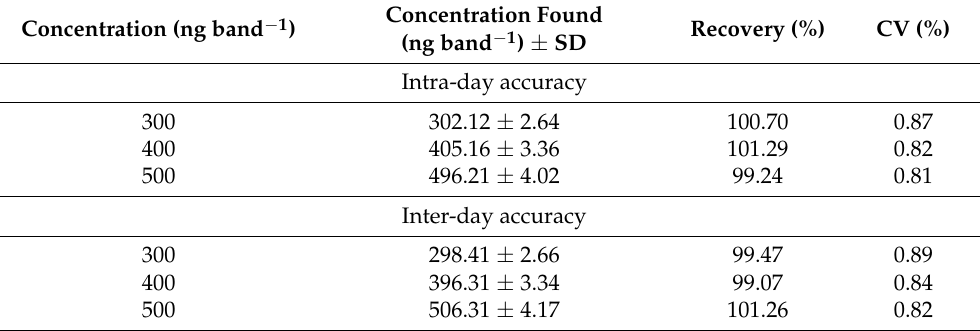
Table 3. Accuracy results for determining CIN using the present approach (mean ± SD; n =